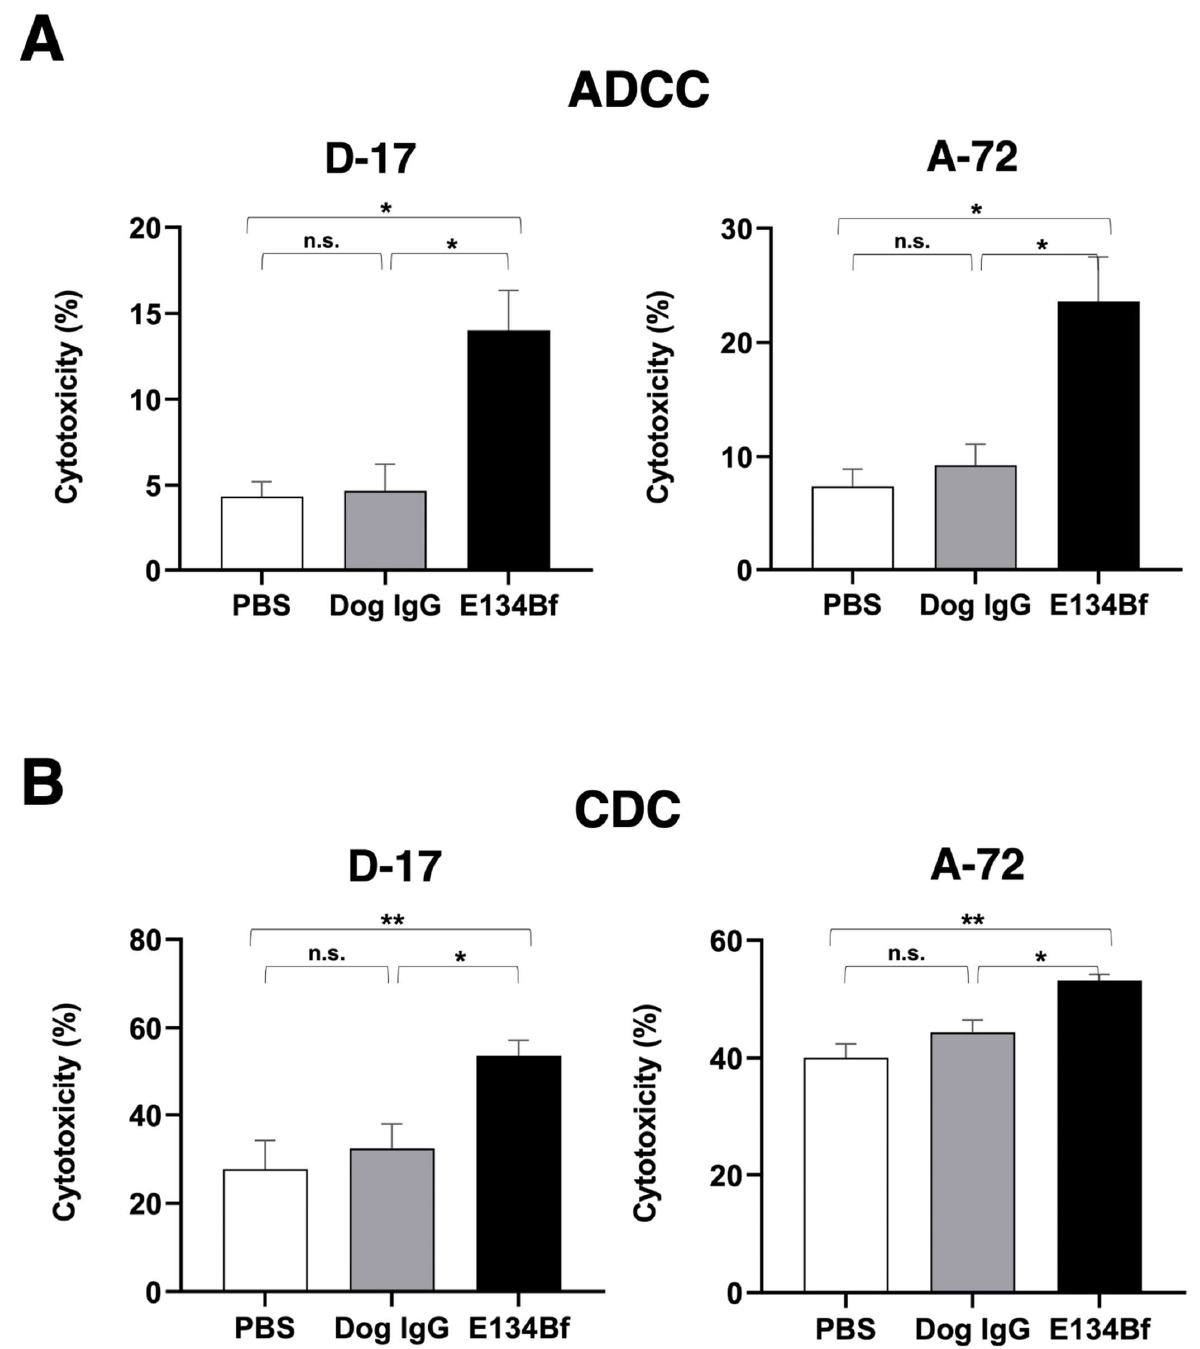
Figure 4. Evaluation of ADCC and CDC elicited by E134Bf. ( A ) ADCC elicited by E134Bf, control dog IgG, or control PBS targeting the D-17 and A-72 cells. ( B ) CDC elicited by E134Bf, control dog IgG, or control PBS targeting the D-17 and A-72 cells. The values are expressed as mean ± SEM. Asterisks indicate statistical significance (** p < 0.01; * p < 0.05; n.s., not significant; Tukey’s post hoc test). ADCC, antibody-dependent cellular cytotoxicity; CDC, complement-dependent cyto- toxicity.